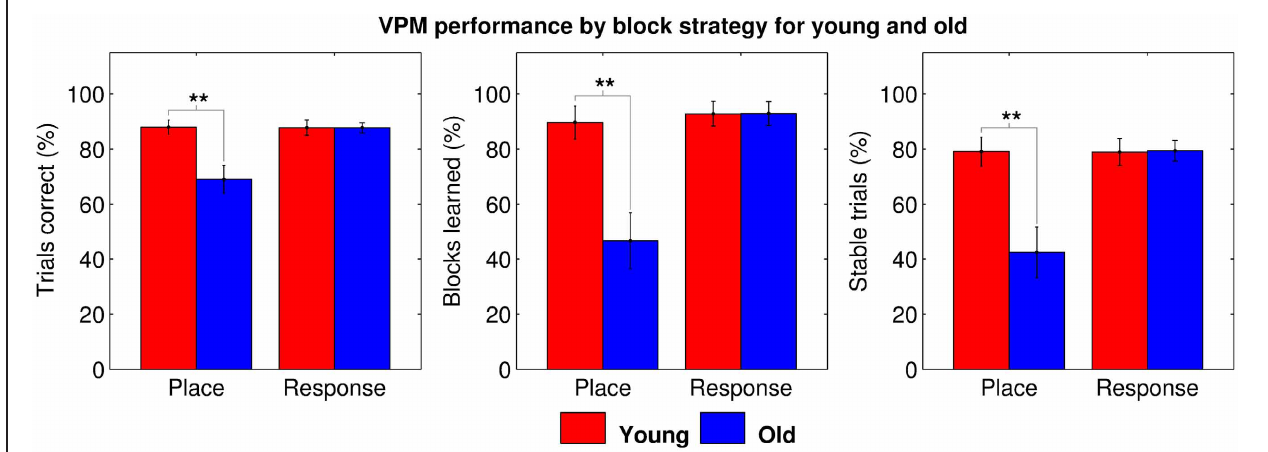
FIGURE 3 | VPM performance in terms of trials correct (left), blocks learned (middle), and stable trials (right) during place and response blocks for young (red) and old (blue) participants. Significant group differences are indicated at the ∗ 0 . 05, ∗∗ 0 . 01, and ∗∗∗ 0 . 001 levels following Bonferroni correction.